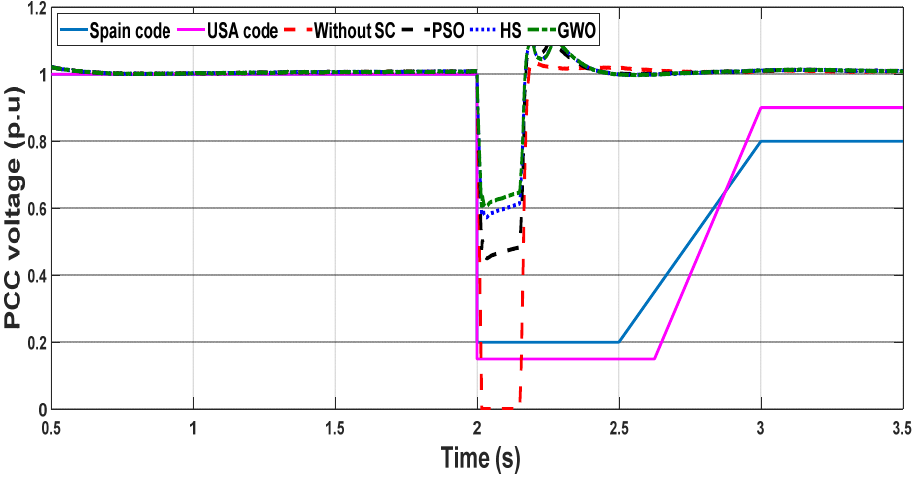
Figure 10. PCC voltage profile during the three-phase fault case study.